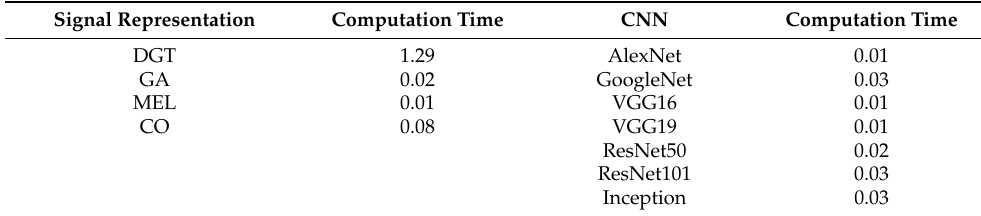
Table 7. Computation time (in seconds) between CNNs and signal